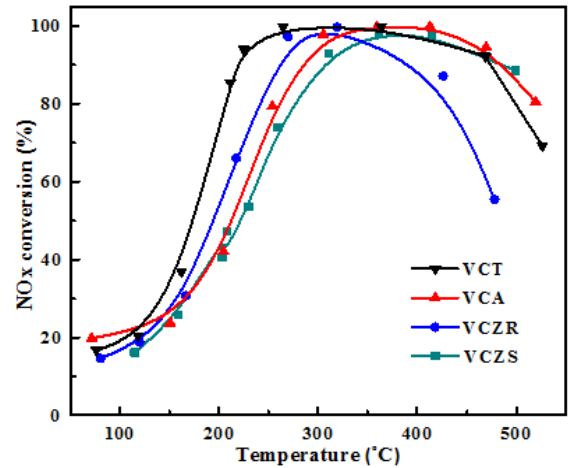
Figure 8. Nitrogen oxides (NOx) conversion with reaction temperature over different samples (Reaction conditions: NO = NH 3 = 700 ppm, O 2 = 3%, balance N 2 , 0.5 g catalyst and gas hourly space velocity (GHSV) about 50,000 h −1 ).